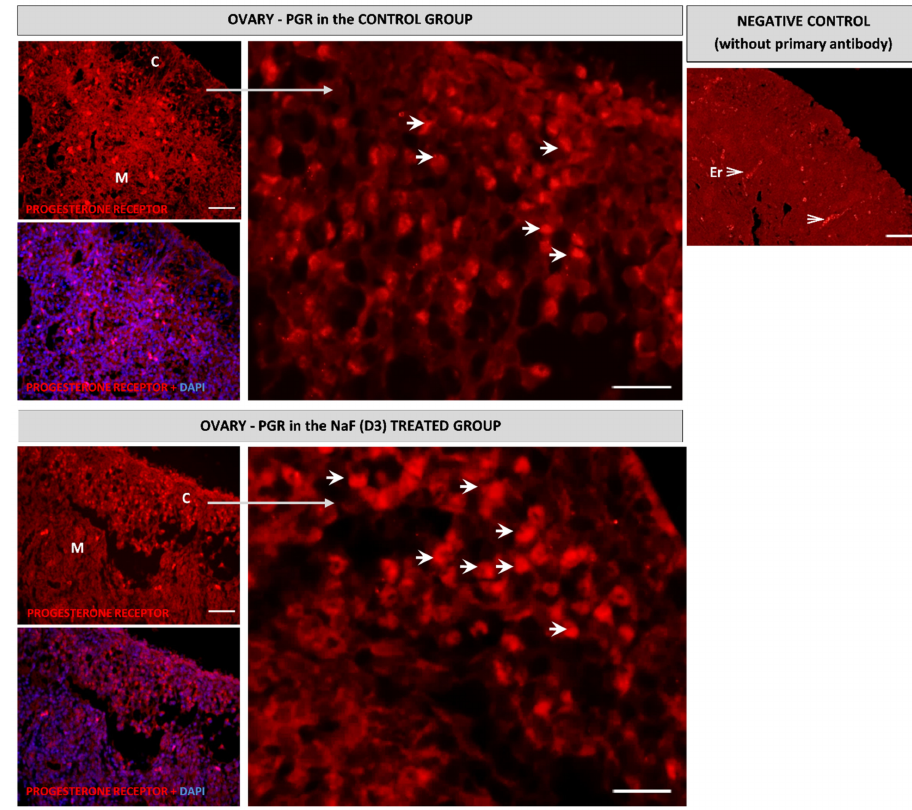
Figure 3. Immunolocalization of the progesterone receptor (PGR) in the control and NaF treated chicken embryonic ovaries. M: Ovarian medulla; C: Ovarian cortex; Er: Erythrocyte (autofluorescence, see Supplementary Materials 1 and 2). Arrows: Immunopositive reaction specific for the progesterone receptor (red fluorescence); DAPI: Blue fluorescence of cell nuclei. Scale bar = 100 µ